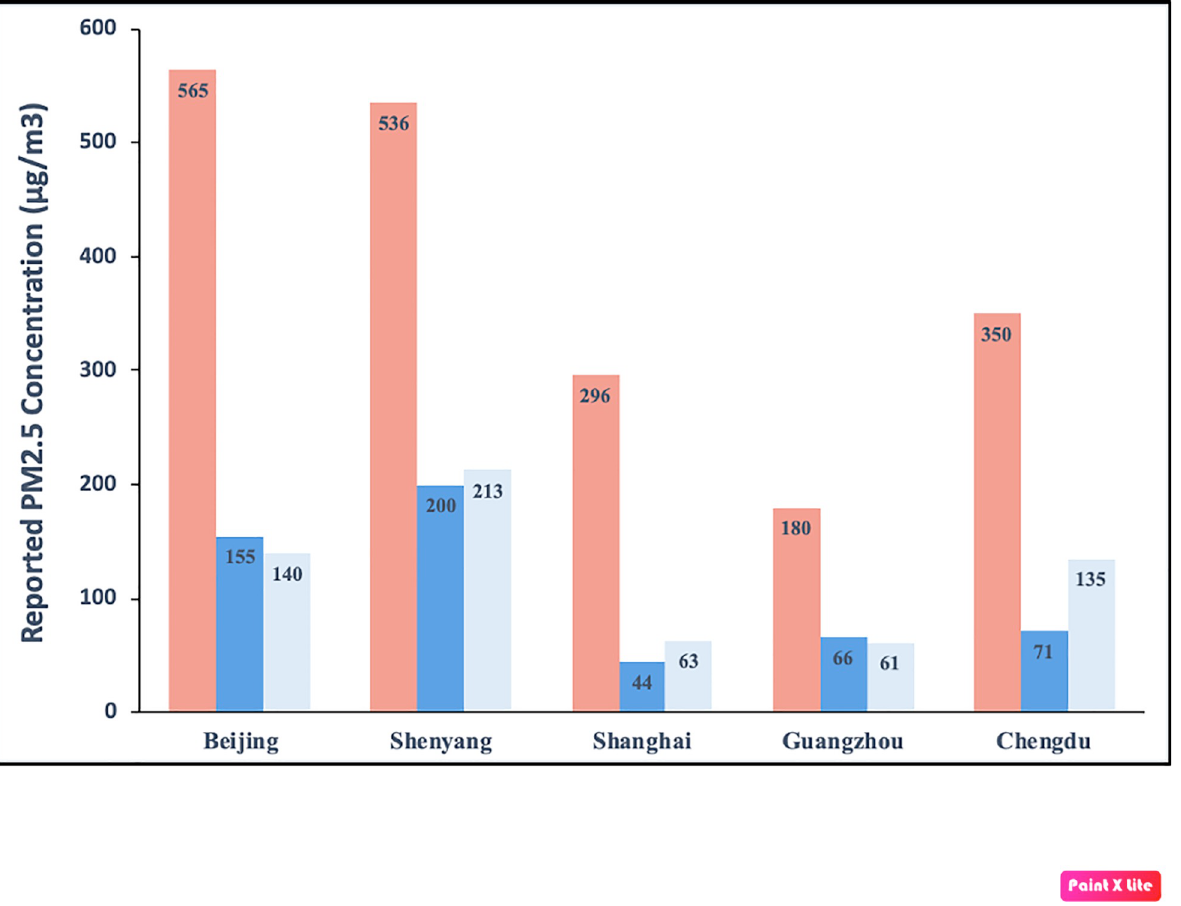
Fig 2. The effect size of positive impulses above the 50% misreporting threshold for each of the five Chinese cities. For each of the five mainland Chinese cities in the dataset, Fig 2 shows the PM 2.5 threshold at which the likelihood of misreporting exceeds 50% (red). It also shows the average coefficient values for impulses when concentrations at U.S. stations are above this threshold (dark blue), as well as the average difference between Chinese and U.S.-reported PM 2.5 levels during these impulses (light